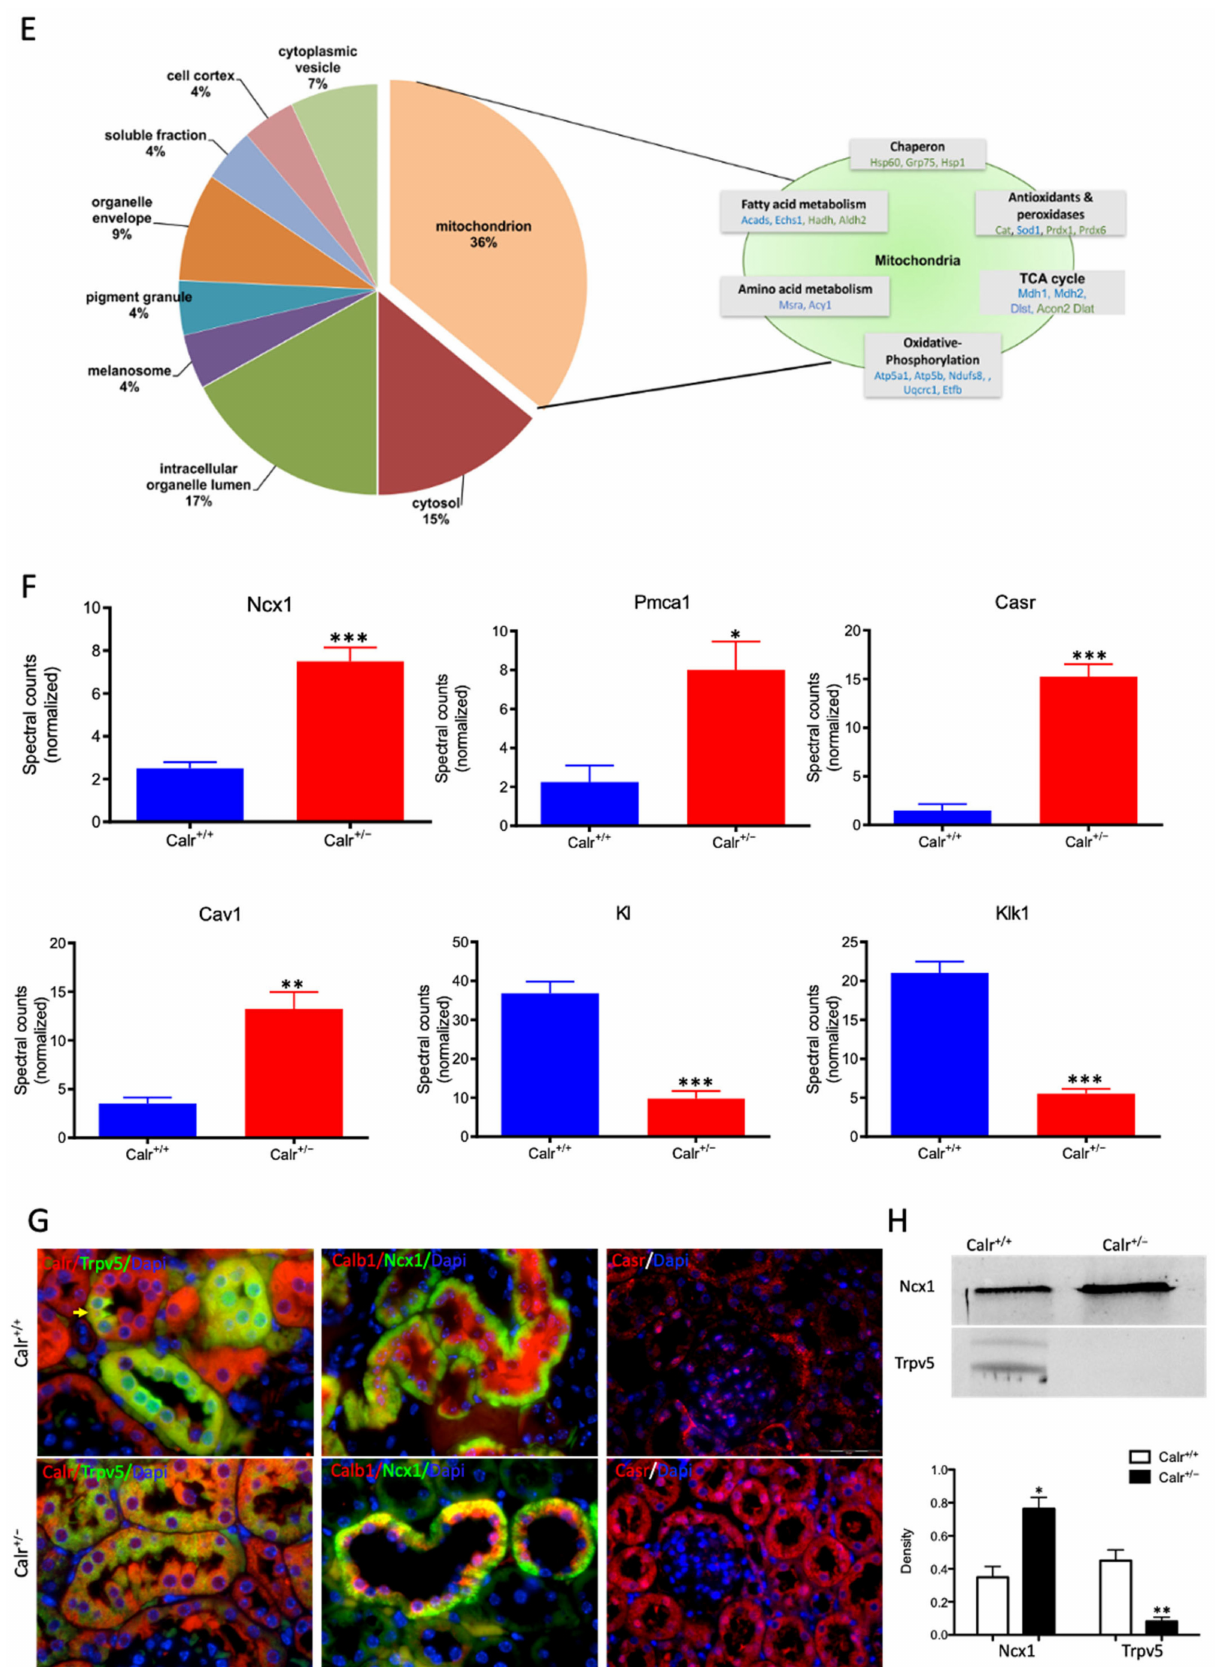
Figure 3. Calr expression underlays the control of calcium handling hormones and is important